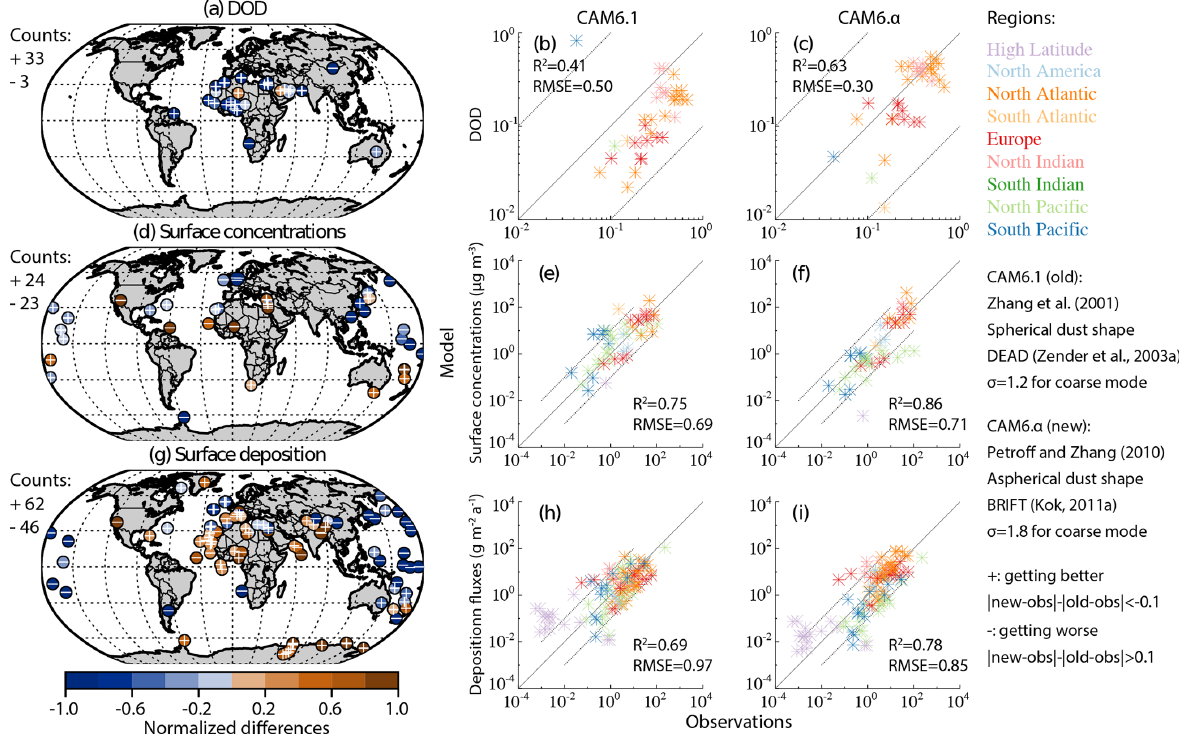
Figure 1. Model–observation (AERONET) comparison for DOD (dust optical depth) at the visible band centered at 0.53µm (a, b, c) , dust surface concentrations (d, e, f) , and surface deposition fluxes (g, h, i) . Colored dots in (a) , (d) , and (g) show the difference between the proposed new model (CAM6. α ) and observations. White symbols indicate the new model CAM6. α improves (plus sign) or worsens (minus sign) the model–observation comparison over that between the default model (CAM6.1) and observations with the metric included in the bottom right-hand corner of the figure. Numbers listed in (a) , (d) , and (g) are counts of the number of improved or worsened stations. The spatial correlation coefficients between model (CAM6.1: b , e , and h ; CAM6. α : c , f , and i ), and observations were calculated based on the annual mean values in log space (the log of each model and observational value was taken before calculating the correlation coefficient, since the values span several orders of magnitude except DOD). Dashed lines in the scatter plot show 10 : 1 or 1 : 10